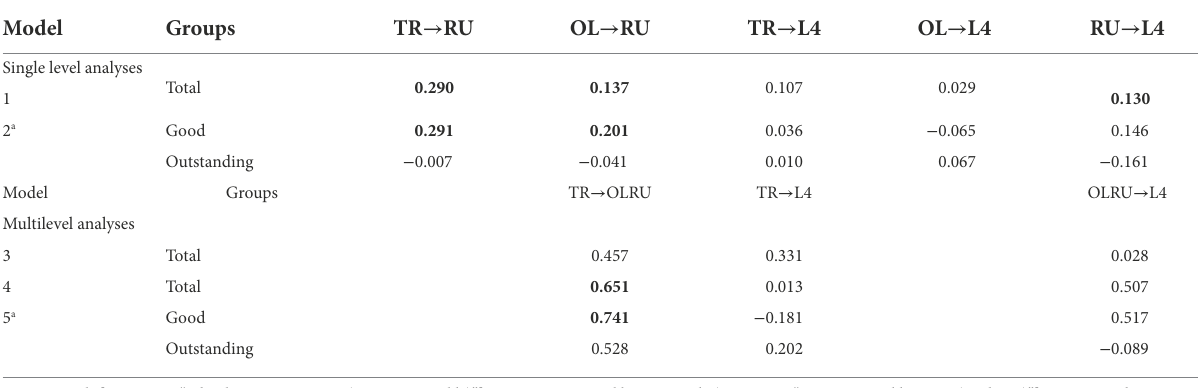
TABLE 3 Path coefficients (fully standardized) for structural models